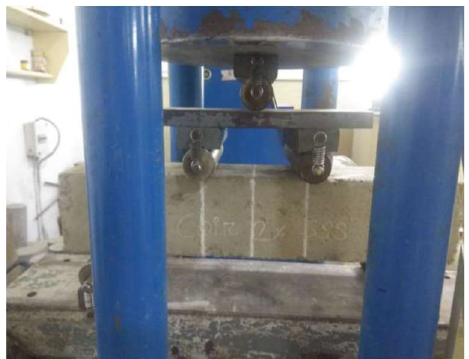
Figure 4. Typical setup of CTM for flexure test.